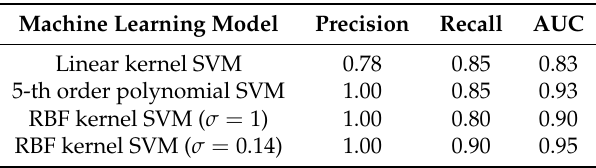
Table 1. Performance evaluation of SVM